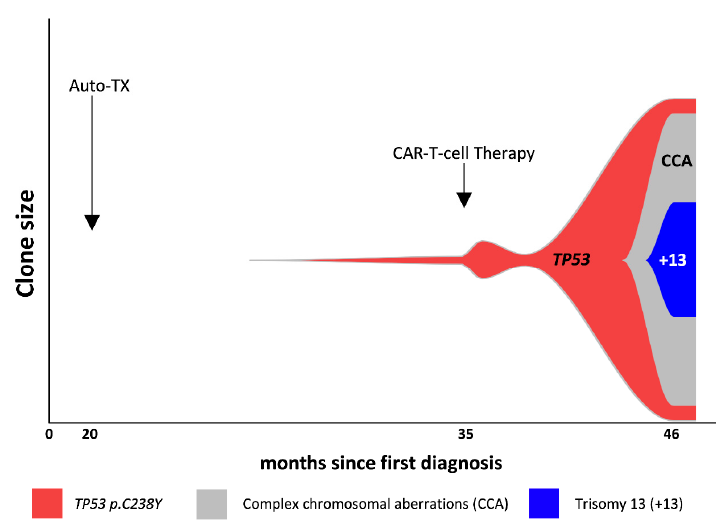
Figure 1. Evolution of the TP53 -mutated clone.